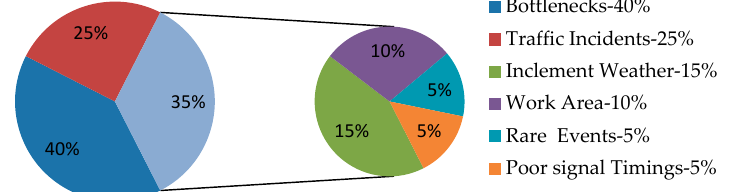
Figure 3. Sources of urban traffic congestion.